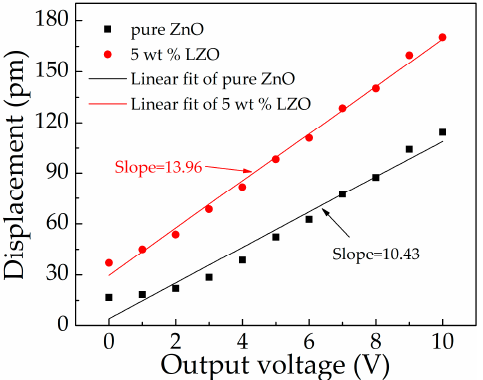
Figure 10. Piezoelectric characteristic of pure ZnO and 5 wt % LZO.